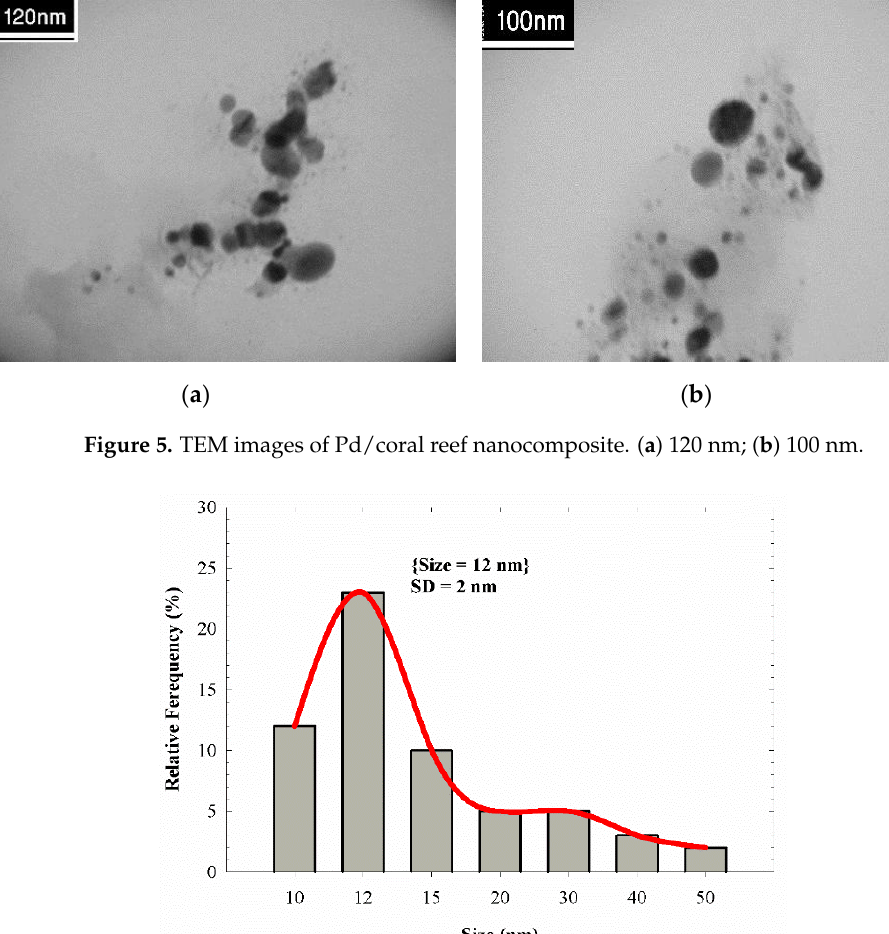
Figure 6. Size distribution histogram of Pd/coral reef nanocomposite.